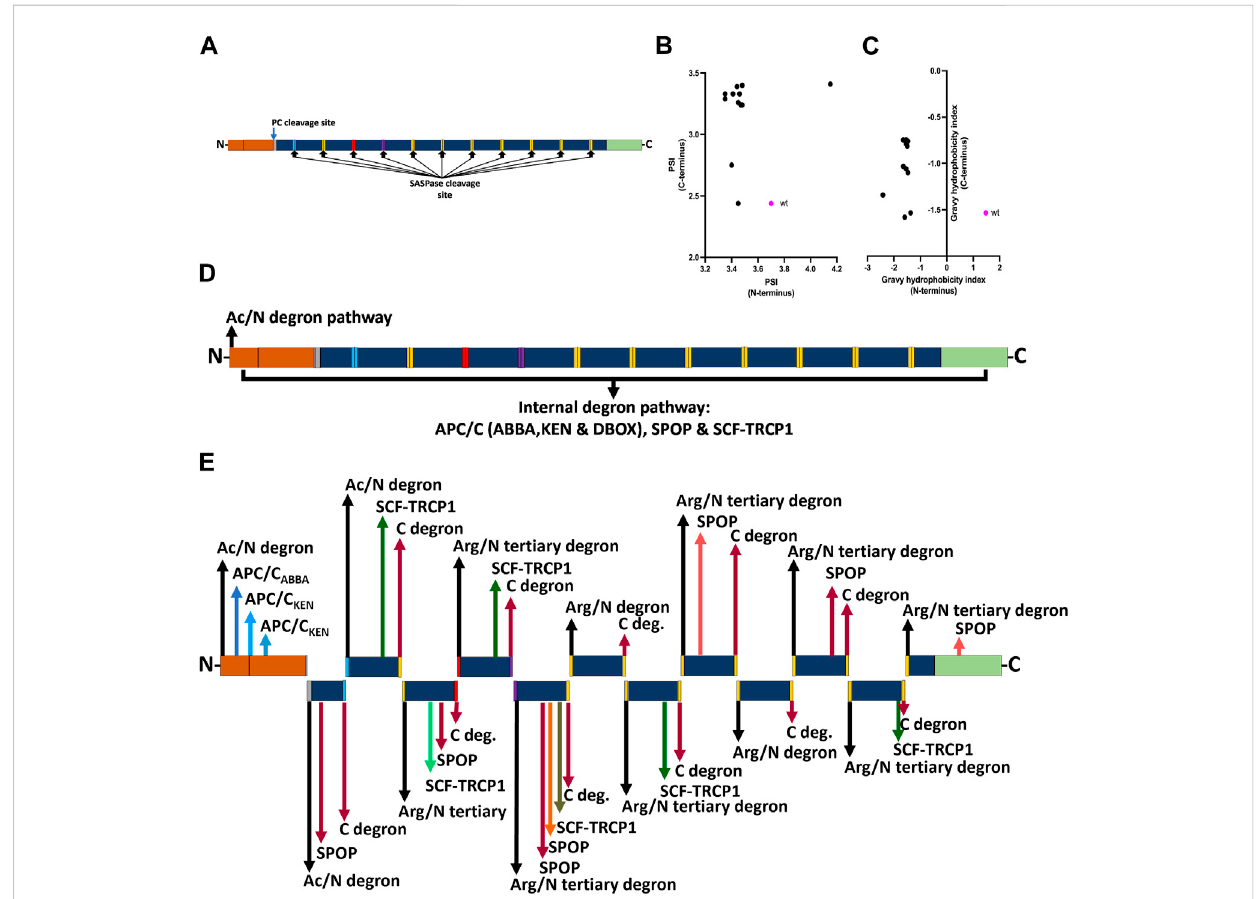
FIGURE 4 Effect of pro fi laggrin processing on the stability and degron content. (A) PC and SASPase clevage sites in the pro fi laggrin sequence. (B) terminal proteinstabilityindexofnewlygeneratedSASPasecleavedFLGproductsincomparisontothewild-typeFLGterminus. (C) terminalGravyhydrophobicity index of newly generated SASPase cleaved FLG products in comparison to the wild-type FLG terminus. (D) Proposed degradation routes of wild-type pro fi laggrin. (E) Proposed degradation routes of PC- and SASPase-cleaved pro fi laggrin products (legends as of Figure